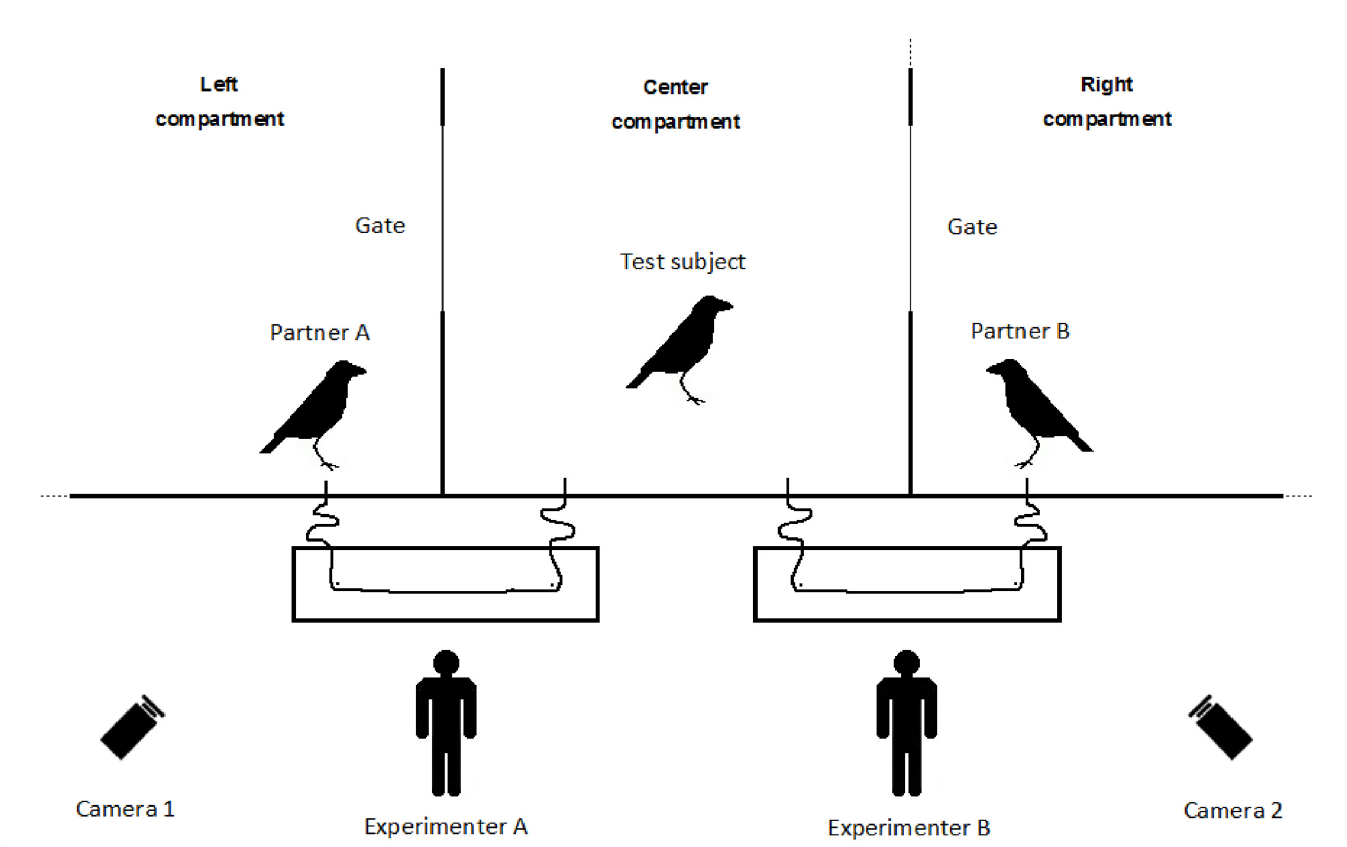
Fig 2. Setting of experiment No. 1 & 2. The test subject could choose to cooperate with one of the partner birds (exp. 1 = familiar vs. relatively unfamiliar, exp. 2 = friend vs. non-friend) at the beginning of every